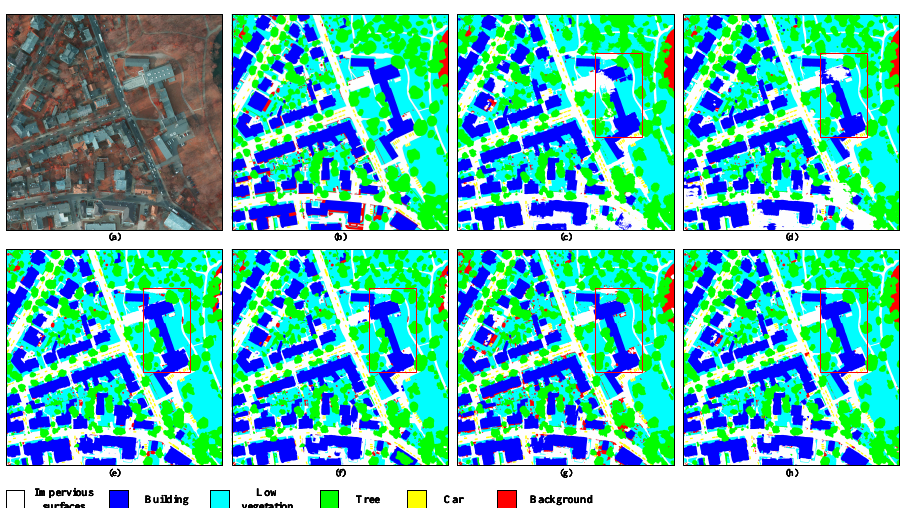
Figure 9. Examples of segmentation results derived from the Potsdam dataset with the whole image size setting. ( a ) IRRG image. ( b ) Ground truth. ( c ) FPENet. ( d ) ERFNet. ( f ) STDC1. ( g ) BiSeNet V1. ( h ) BiSeNet V2. ( i ) DSANet64.